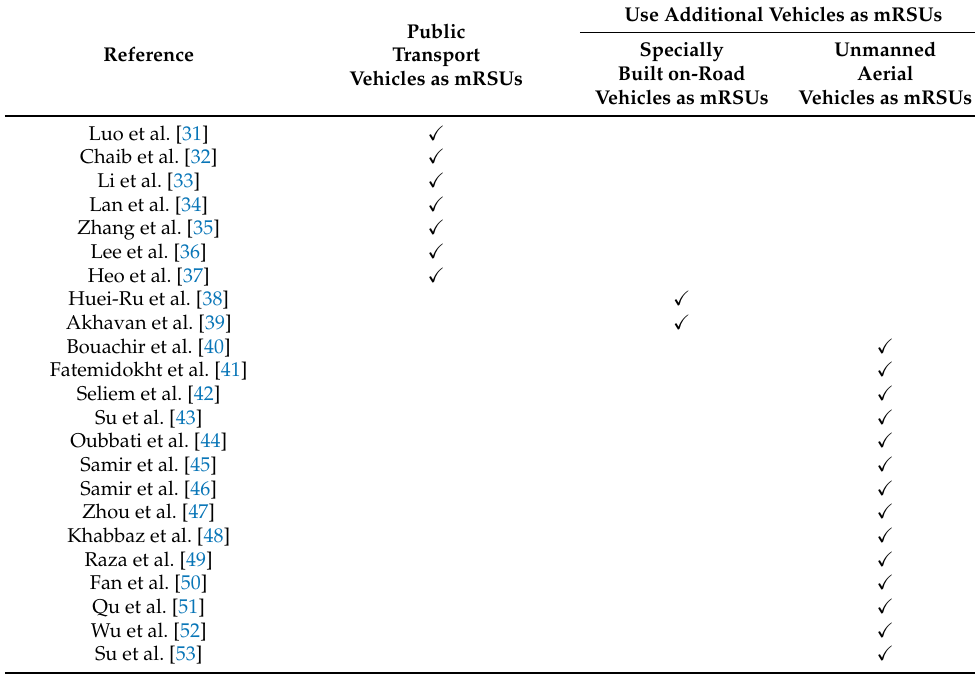
Table 3. References categorization for each mRSU